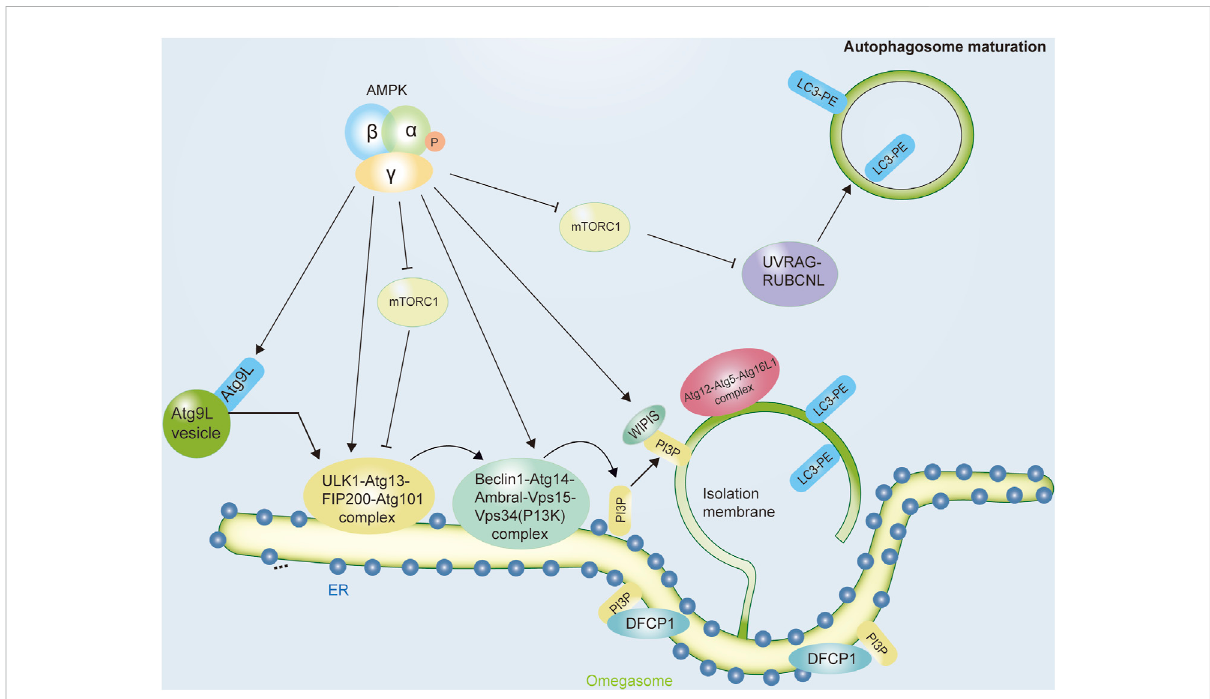
FIGURE 2 The role of AMPK in initiating the autophagic process. Autophagy, a lysosome-mediated degradation system, starts with the initiation and nucleation of a double membrane vesicle, known as the isolation membrane (or phagophore), in the cytoplasm. Autophagy occurs in a stepwise manner involving sequential membrane reshaping processes. Autophagy induction is initiated by the ULK1 complex, which contains ULK1, ATG13, FIP200, and ATG101. The activity of this protein complex is regulated by AMPK, which both inhibits the mTORC1 complex and activates the activity of ULK1 complexes. In mammalian cells, another complex ClassIII PI3K complex formed by VPS34, Beclin1, ATG14, AMBRA1, and other subunits act coordinately with the ULK1 complex to initiate autophagosome nucleation. AMPK can increase the pro-autophagic function of this complex and enhance its formation. Abbreviations: AMPK, adenosine monophosphate-activated protein kinase; ATG, autophagy-related protein; DFCP1, double FYVE-containing protein one; ER, endoplasmic reticulum; FIP200, focal adhesion kinase family interacting protein of 200kDa; LC3, microtubule-associated protein 1 A/1B-light chain three; PE, phosphatidylethanolamine; PI3P complex, the class III phosphatidylinositol (PtdIns) 3- kinase complex; mTOR, mechanistic target of rapamycin; mTORC1, mechanistic target of rapamycin complex one; ULK1, Unc-51-like kinase one; UVRAG, ultraviolet radiation resistance genes; WIPI proteins, WD-repeat protein interacting with